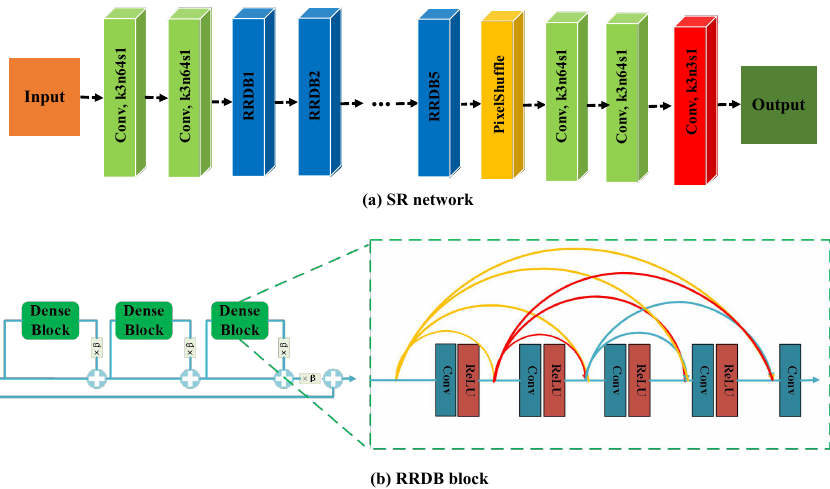
Figure 5. The architecture of the SR